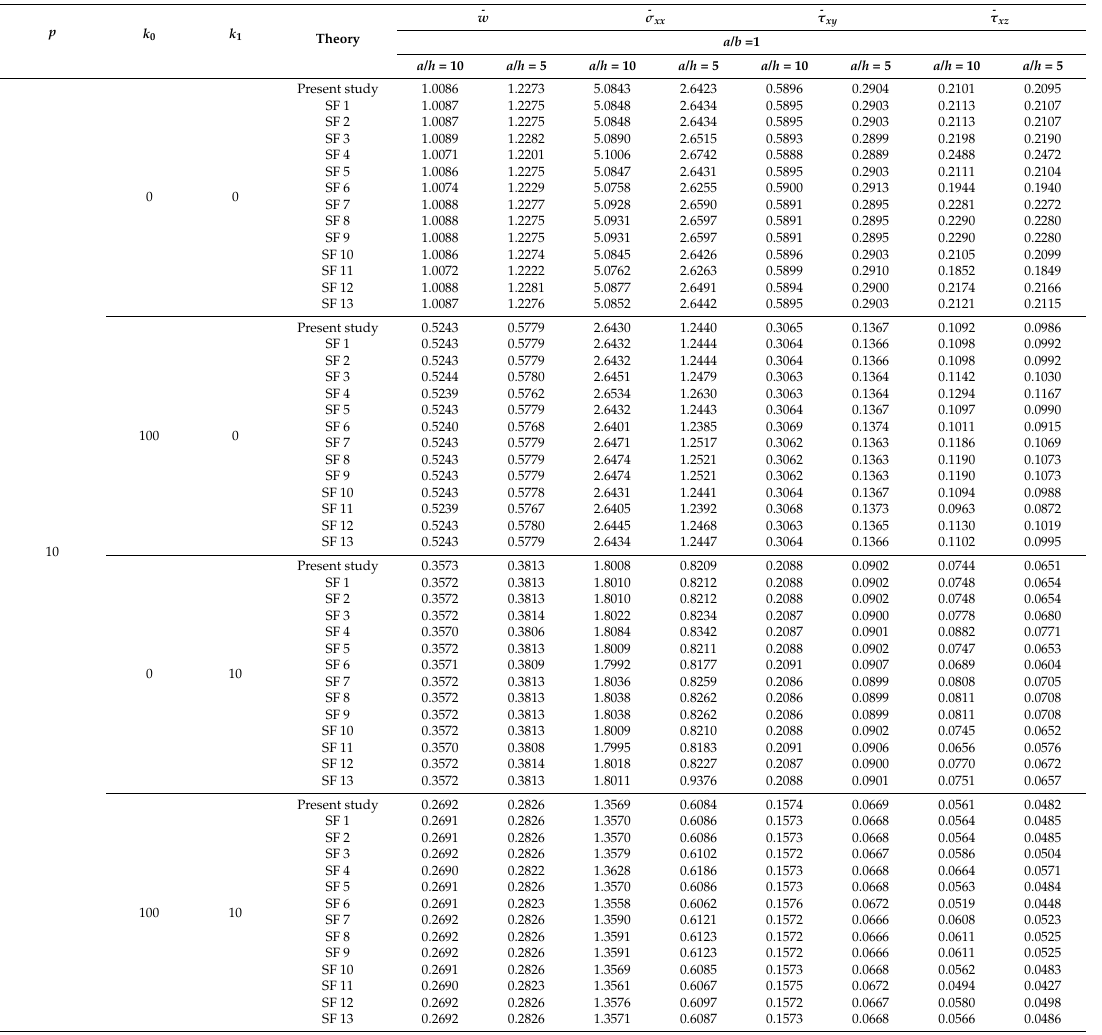
Table 5. Normalized values of displacement and stresses of square plate on elastic foundation for p = 10, different values of the k 0 и k 1 and the ratio a / h ( a / b =